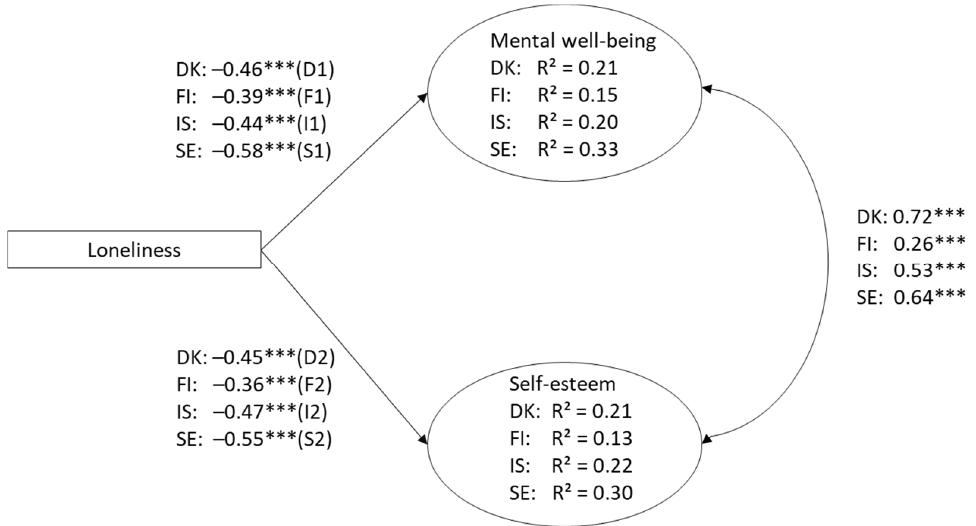
Figure 2. Regression coefficients of loneliness predicting/explaining low mental well-being and low self-esteem in subgroups formed by country (Denmark, DK; Finland, FI, Iceland, IS; Sweden, SE). Factor loadings set equal, standardized beta coefficient estimates reported. *** p < 0.001